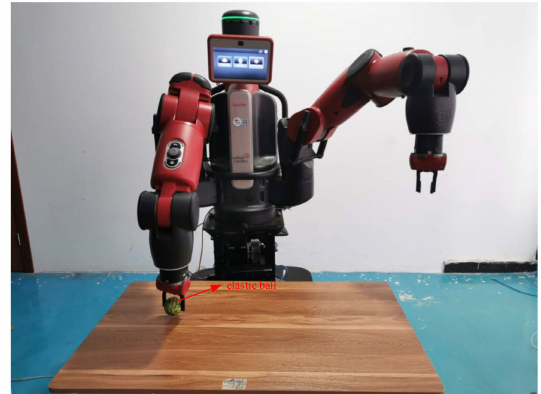
Figure 25. Grasping elastic ball.